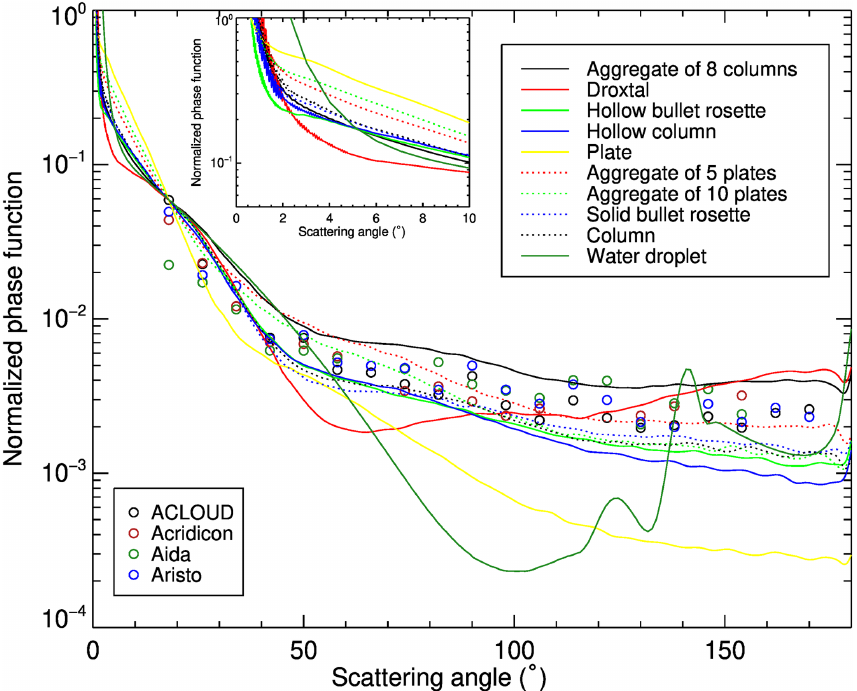
Figure 3. Comparison of phase functions for water droplets and ice crystals with campaign measurements provided by Järvinen et al. (2018). Symbols – measurements, lines – different shapes (see legend). A zoom-in panel for smaller scattering angles is shown in the upper-left corner of the